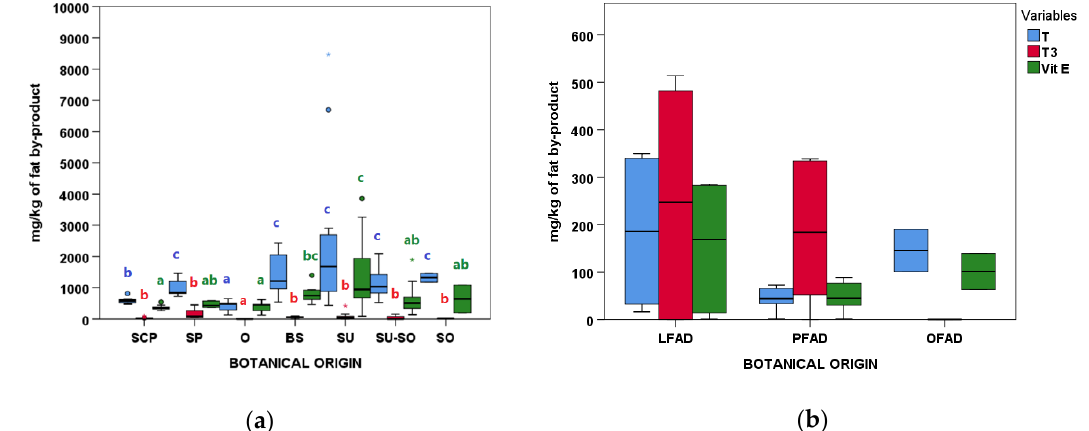
Figure 6. Tocopherols (T), tocotrienols (T3), and Vitamin E content according to botanical groups for ( a ) acid oils from chemical refining ( n = 79) and ( b ) fatty acid distillates from physical refining ( n = 13) (see Table 1 for botanical group abbreviations). Within each type of refining and variable, botanical groups bearing different letters (a–c) are significantly different according to Kruskal–Wallis test and post-hoc comparisons ( p ≤ 0.05).